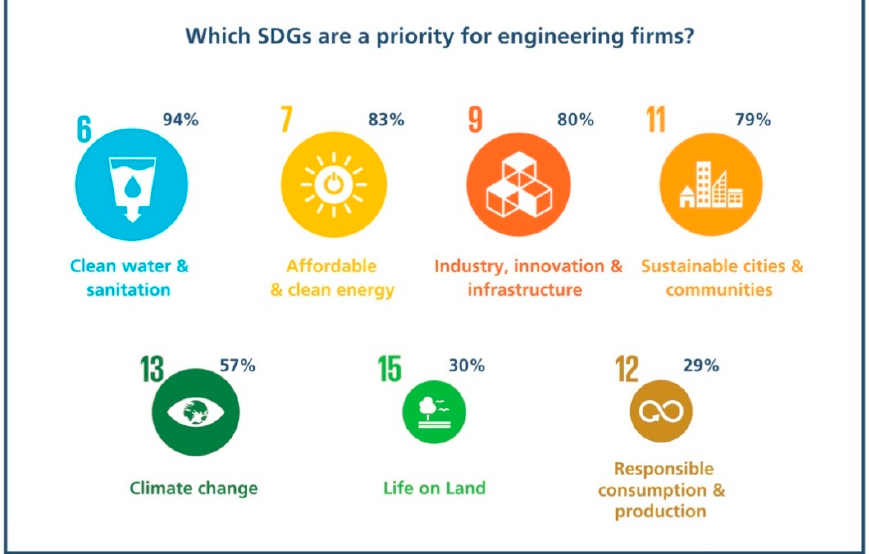
Figure 8. Responses of participants to their five top SDGs that engineering projects should measure impact against, showing the top seven list (with six and seven being significantly less popular).